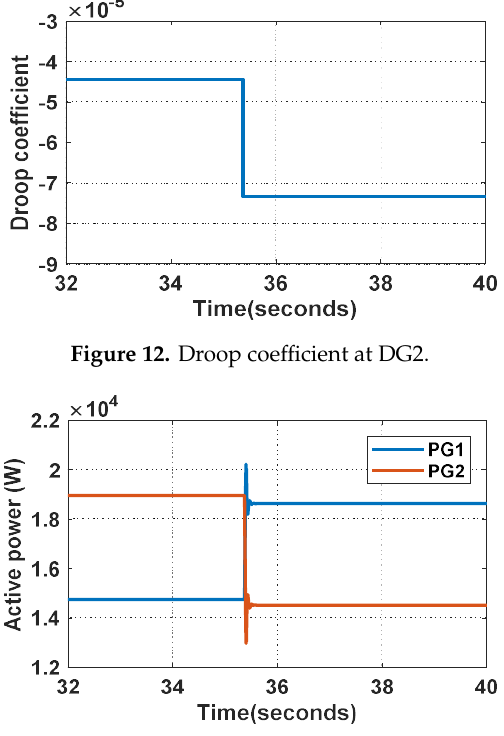
Figure 15. Phase Voltages at DG1 bus.